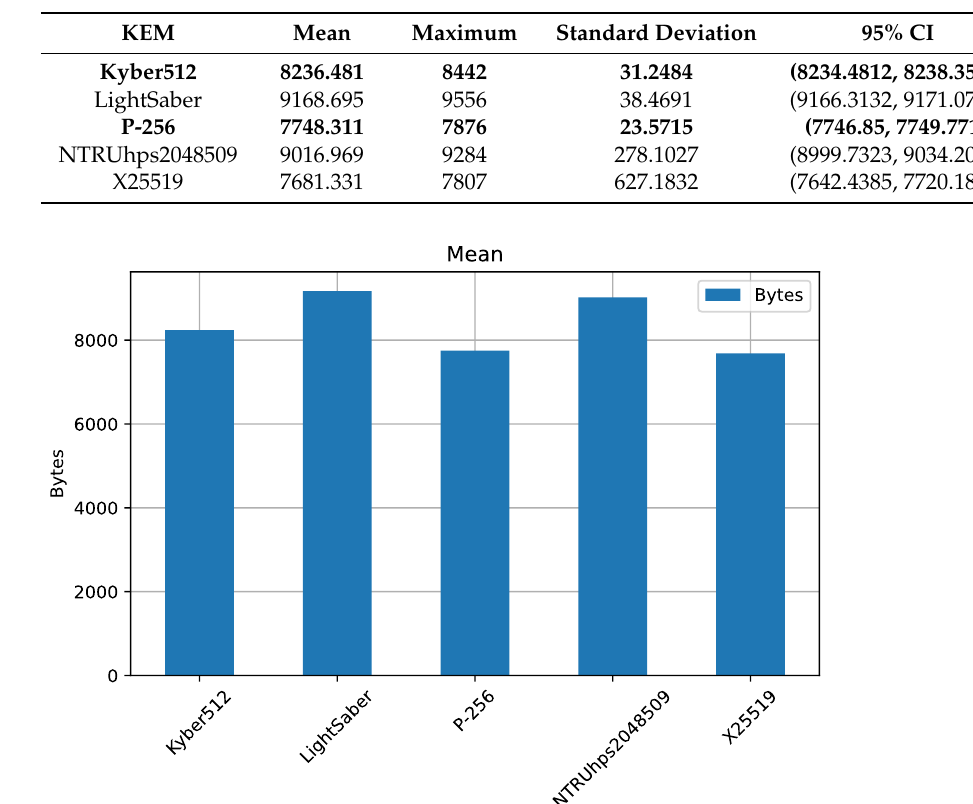
Table 9. The mean and maximum number of bytes each KEM sends during the connection. The elliptic curves perform better then the post-quantum ones. Kyber512 performs best, followed by NTRUhps2048509 and LightSaber.